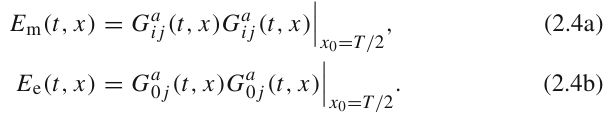
√ 8 t = cL (with c a